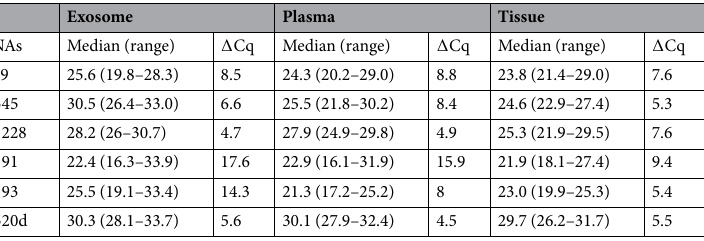
Table 2. Expression levels of candidate reference miRNAs in different matrixes from CRC patients and healthy